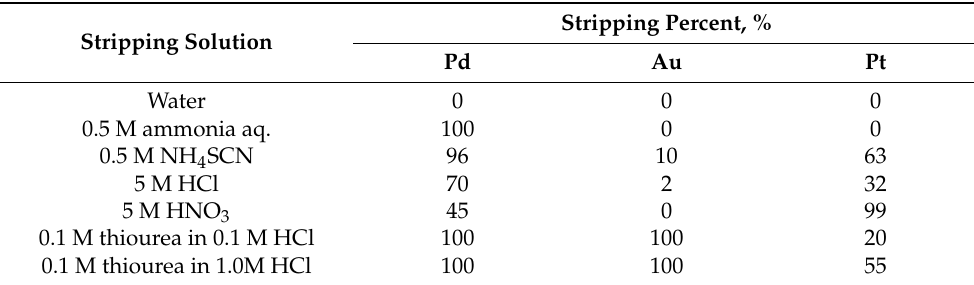
Table 5. The metal ion stripping percentages obtained for the stripping solutions studied after EDAB-acac in methylene chloride